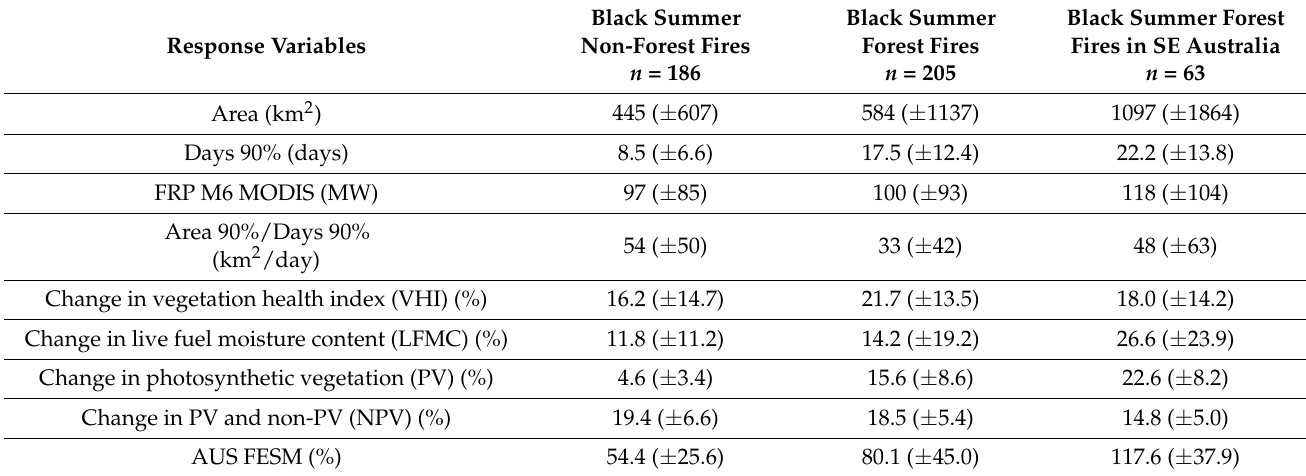
Black Summer Black Summer Black Summer Forest Non-Forest Fires Forest Fires Fires in SE Australia n = 186 n = 205 n = 63